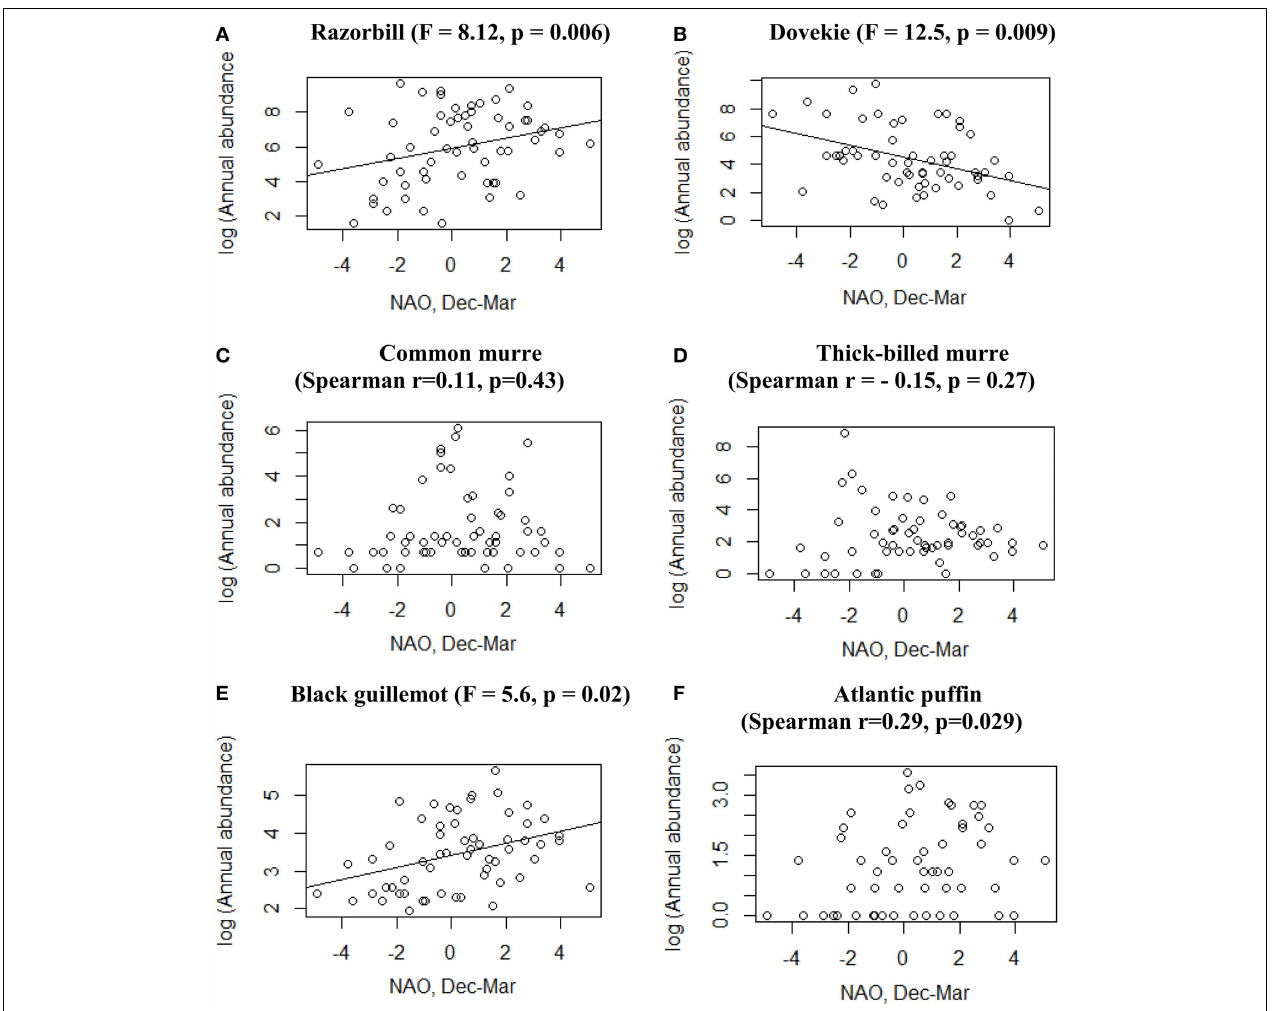
FIGURE 1 | Winter abundance vs. NAO for six alcid species in